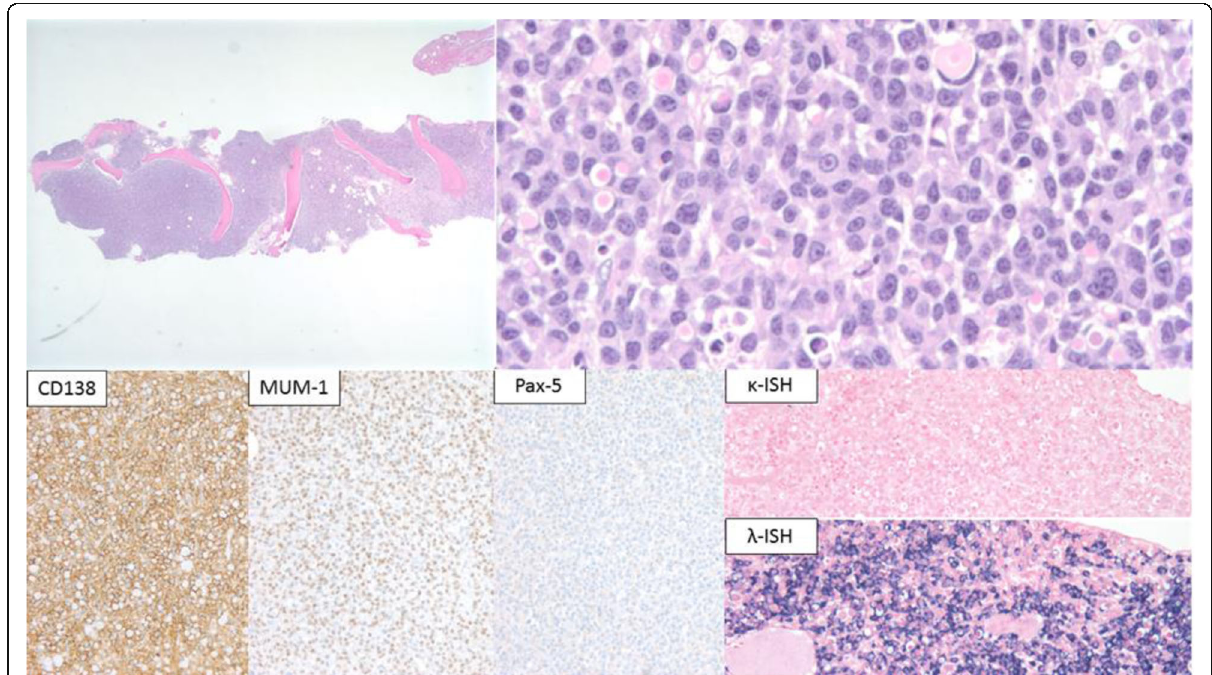
Fig. 1 Morphologic examination (top) and immunohistochemical stains (bottom) performed on the diagnostic bone marrow core biopsy. The H&E stained sections of the bone marrow biopsy revealed a diffuse infiltrate of plasma cells (× 20) with nuclear pleomorphism; a subset of plasma cells showed prominent nucleoli (× 500). The plasma cells expressed CD138, MUM-1 with lambda light chain restriction (×